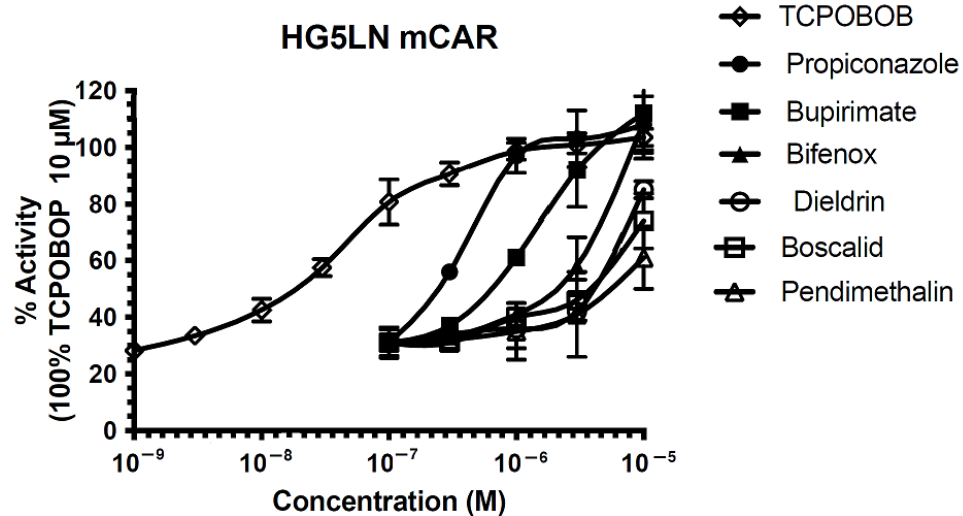
Figure 1. The graph shows mCAR’s transcriptional activity in response to the CAR agonist TCPOBOP and various pesticides. The results are expressed as a percentage of the highest luciferase activity triggered by 10 μM TCPOBOP. Standard deviations are represented by error bars.